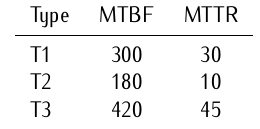
Figure 8. Evolution of the number of all the machines constraints highlights a periodic variation. Almost each 400 iterations, we have a similar variation of the number of operational equipments, down equipments